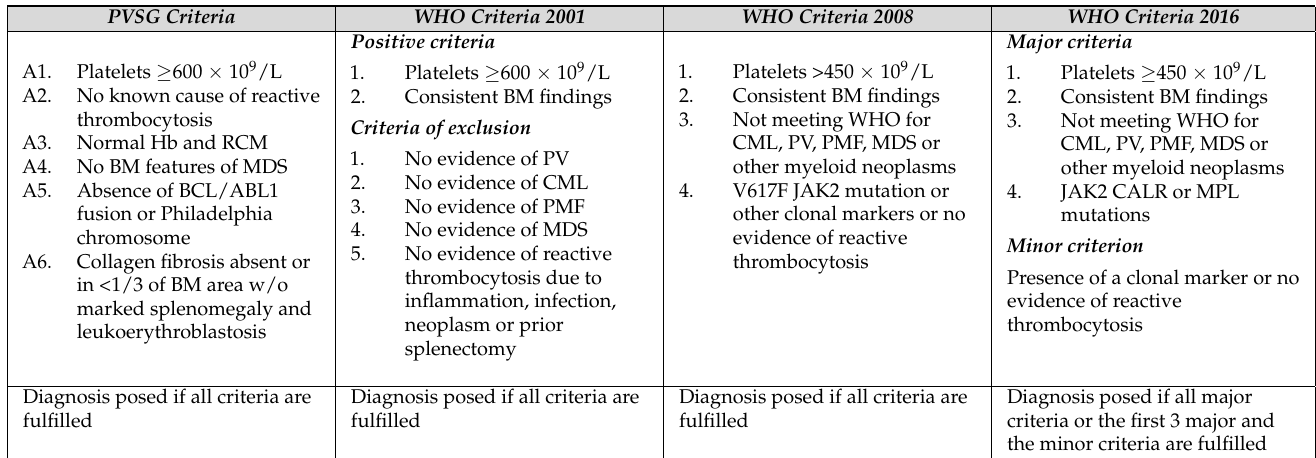
Table 3. Evolution of diagnostic criteria for Essential